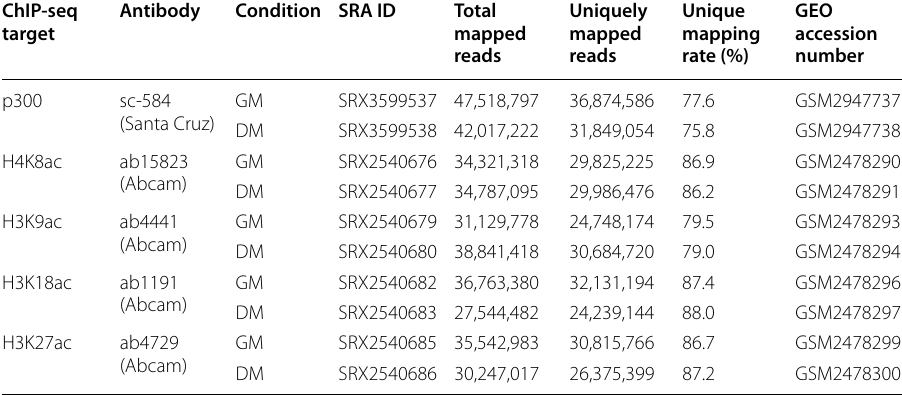
Table 2 Sequencing reads alignment statistics for ChIP-seq datasets ChIP‑seq